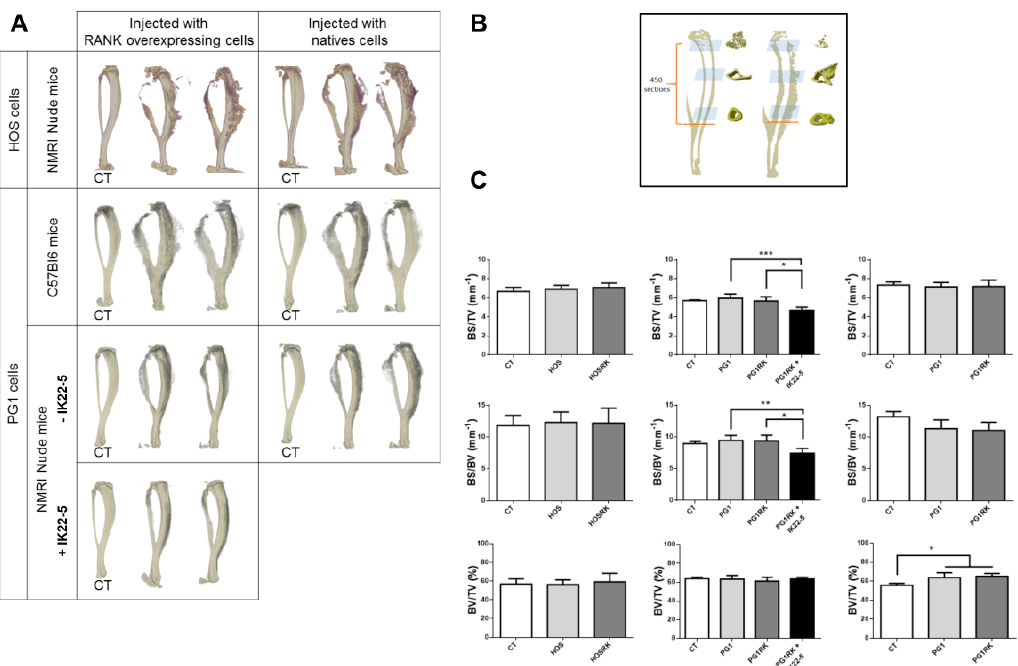
Figure 3. Impact of RANK over-expression in osteosarcoma cells on bone structure ( A ) and